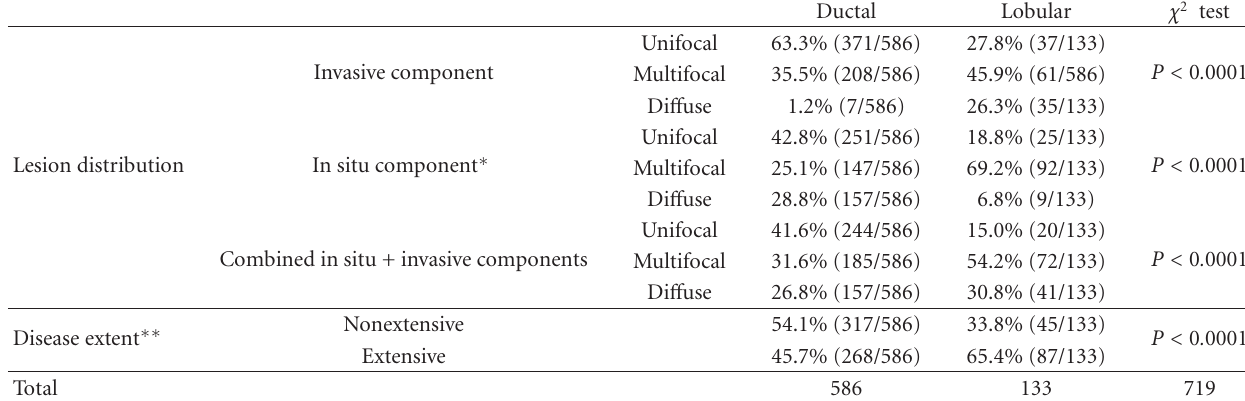
Table 1: Lesion distribution and disease extent in ductal and lobular breast carcinomas, Dalarna, Jan 2008–Jul 2012.